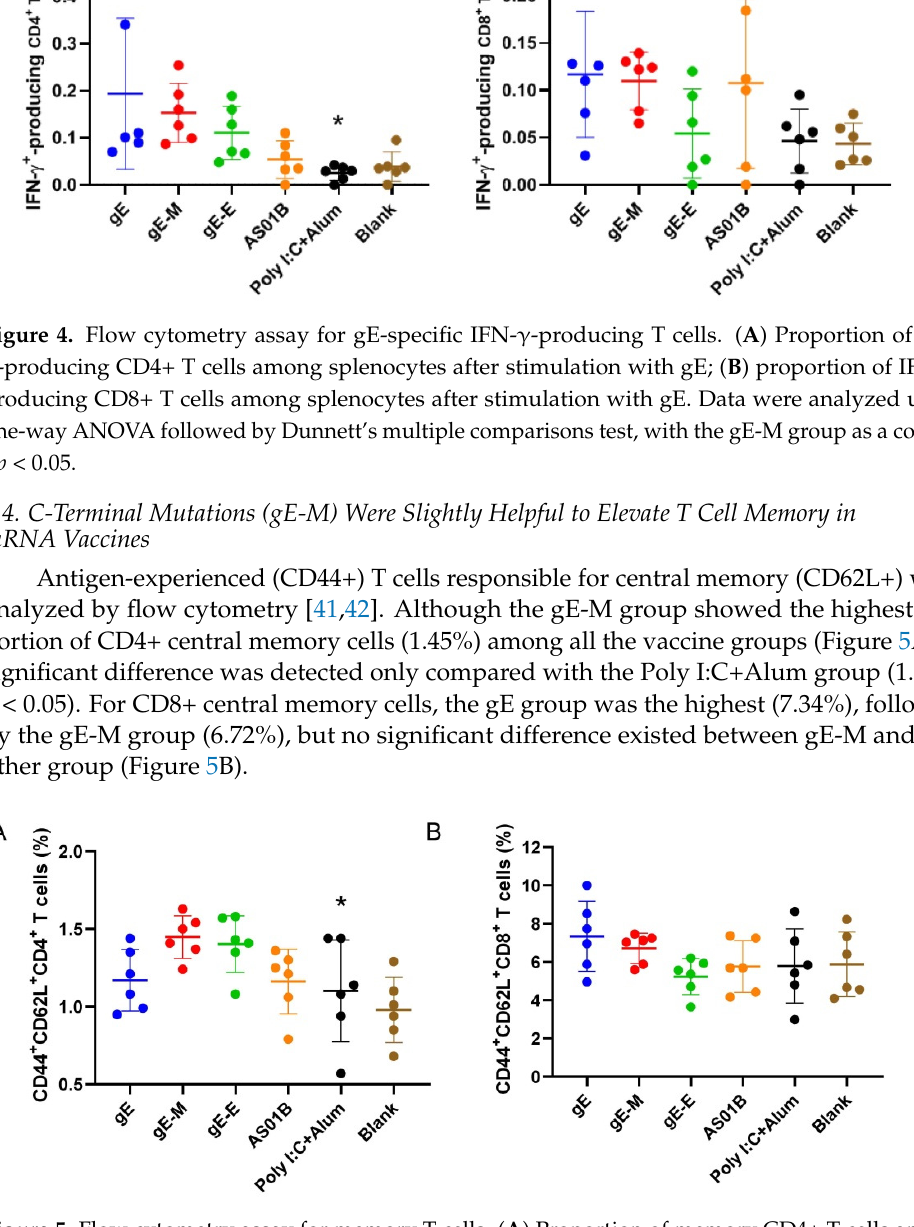
Figure 3. Enzyme-linked immunospot assay (ELISPOT) of splenocytes. ( A ) IFN- γ -producing sple- nocytes after gE stimulation; ( B ) IL-2-producing splenocytes after gE stimulation. ELISPOT num- bers were compared using one-way ANOVA followed by Dunnett’s multiple comparisons test, with the gE-M group as a control. ** p < 0.01.